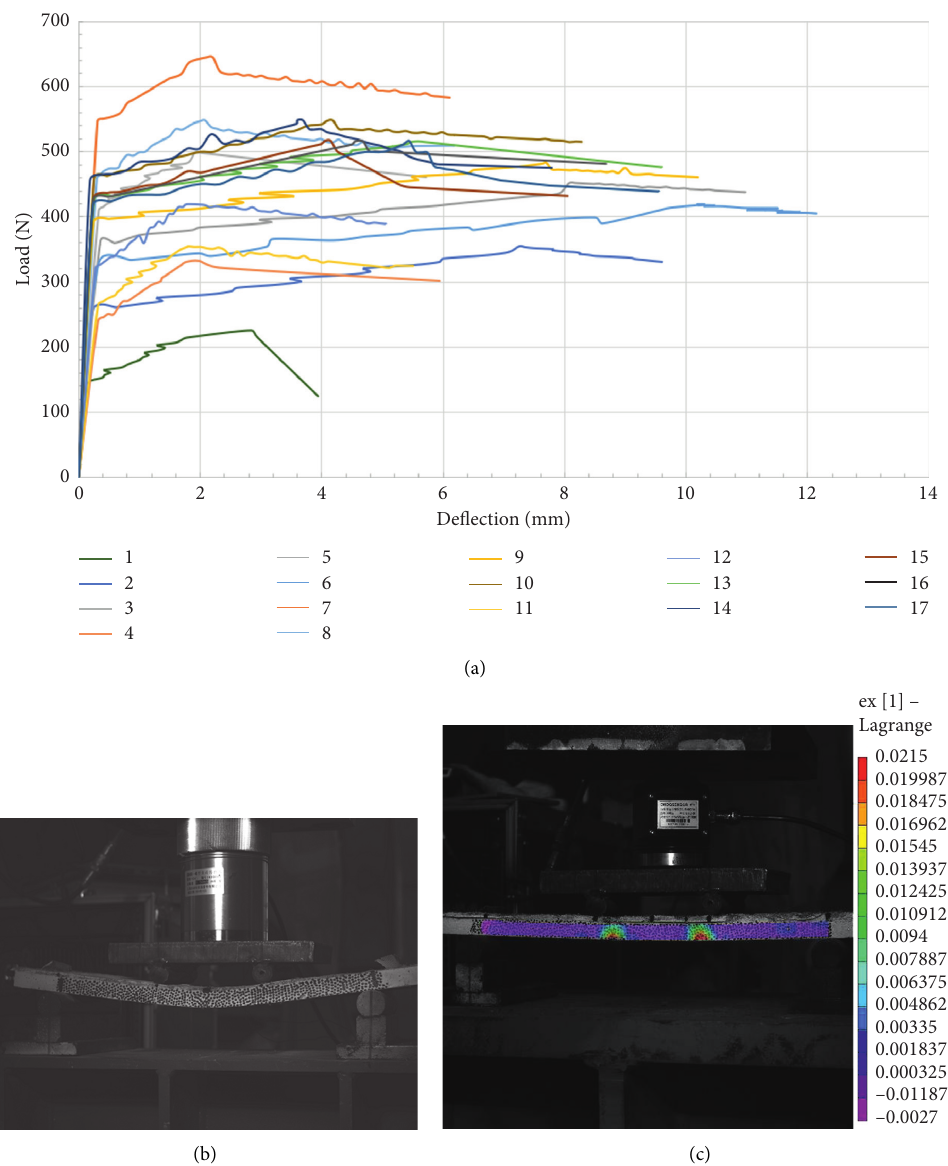
Figure 11: (a) Load-deflection curves of thin plates with different mix proportions. (b) The deformation figure of the thin plate. (c) Distribution of strain obtained by